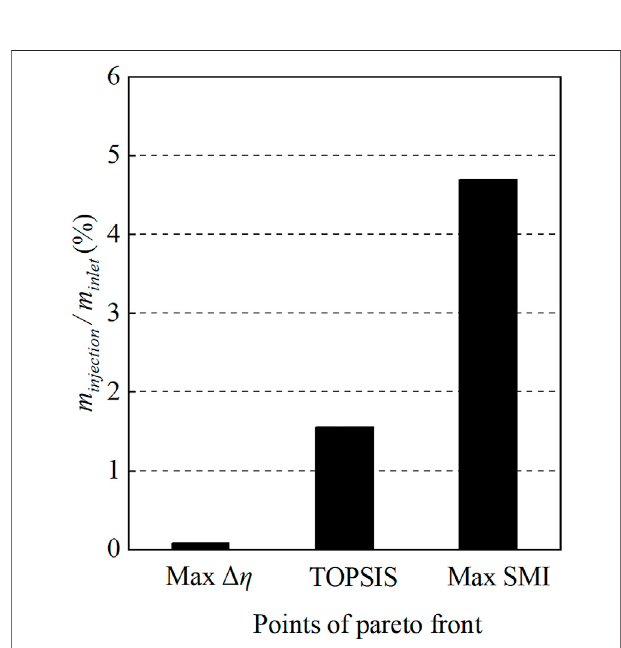
FIGURE 10 | Comparisons of the injection fl ow rate of different design